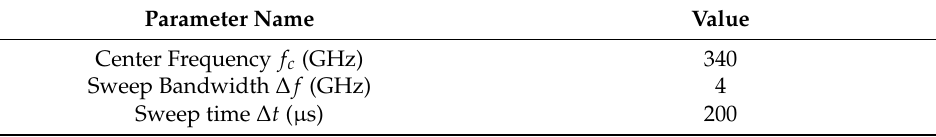
Table 3. The parameters of FMCW